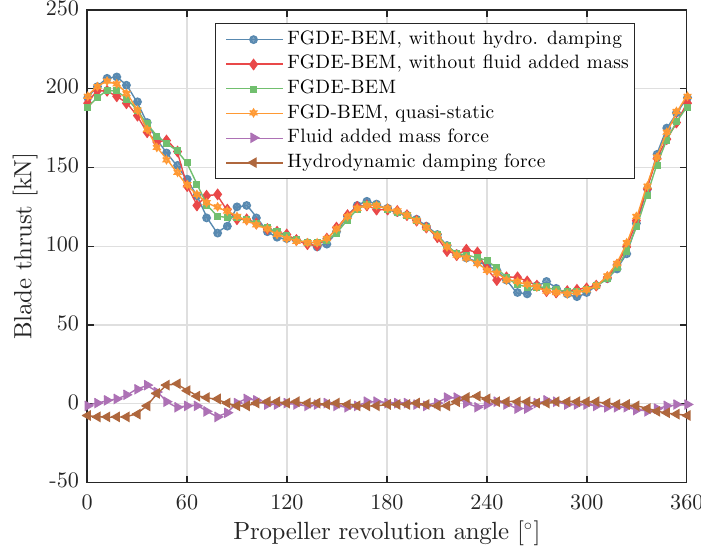
Figure 18. Blade thrust, fluid added mass and hydrodynamic damping force computed with the FGDE-BEM-FEM coupling with and without including the fluid added mass and hydrodynamic damping in the calculations, for the carbon–epoxy Seiun–Maru